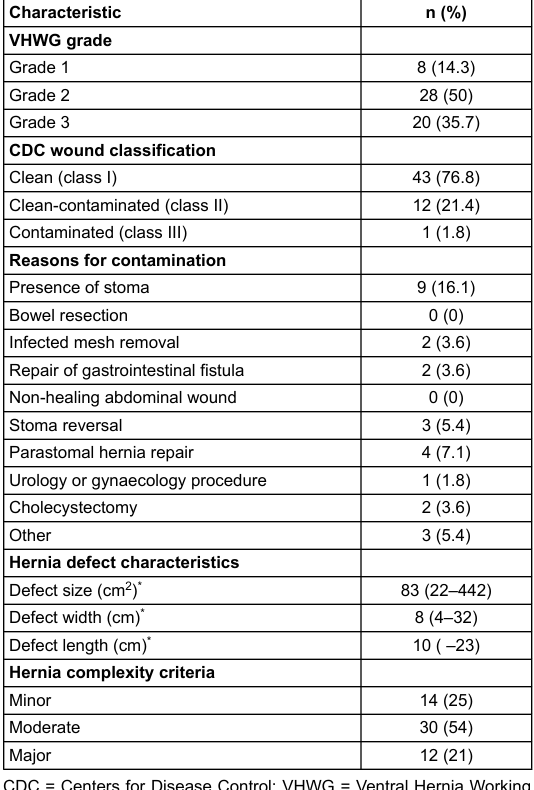
Table 2: Wound and hernia characteristics (n = 56).